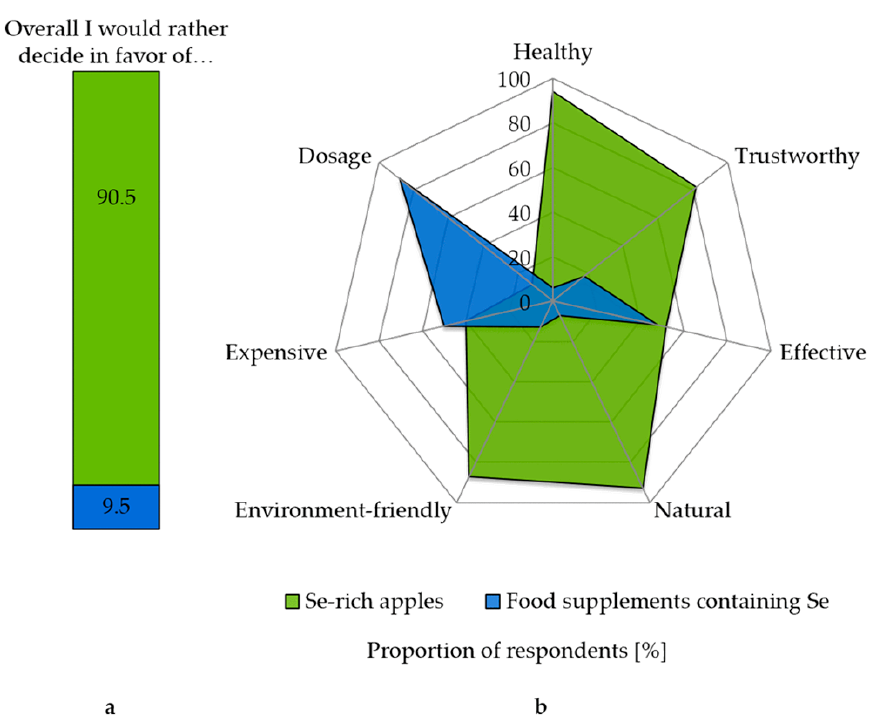
Figure 2. Consumer evaluation of Se-rich apples and food supplements ( a ) and potential